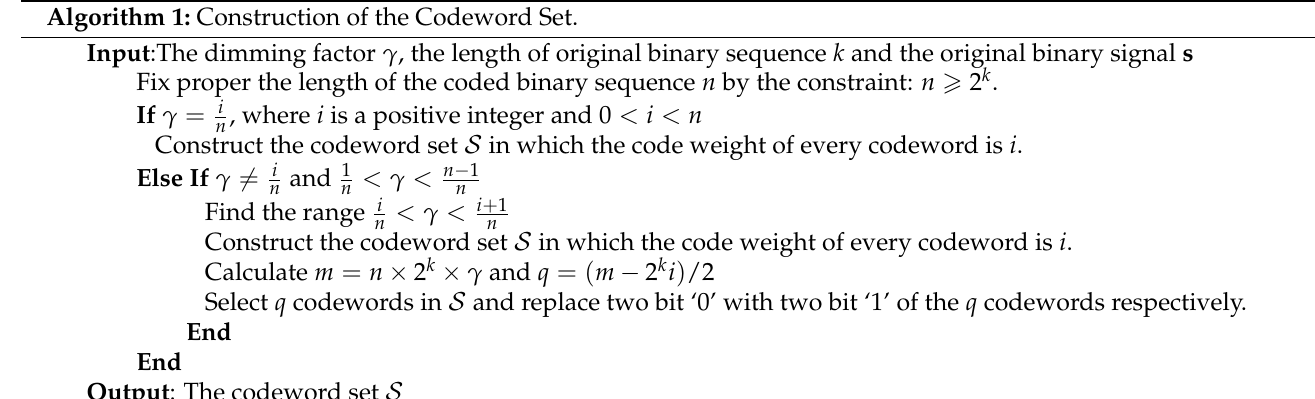
Algorithm 1: Construction of the Codeword